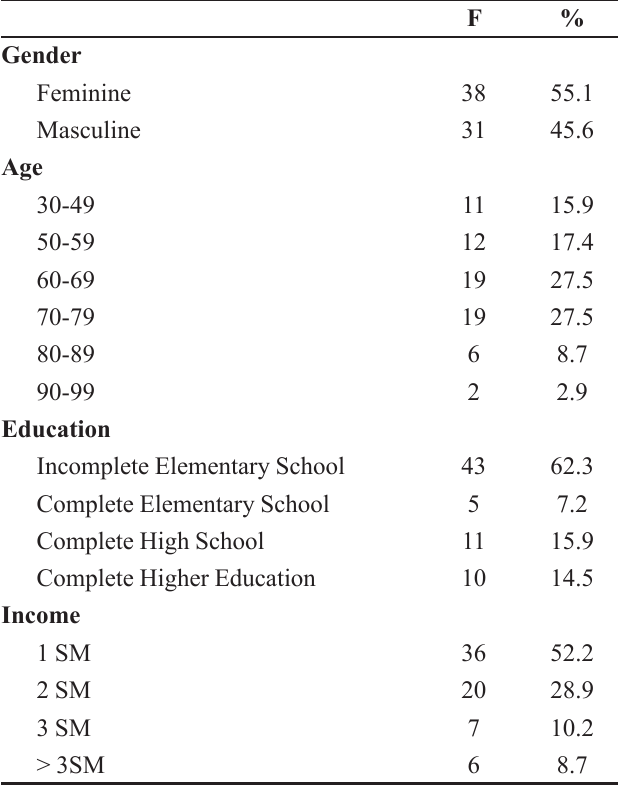
TABLE I - Socioeconomic characteristics of users of the